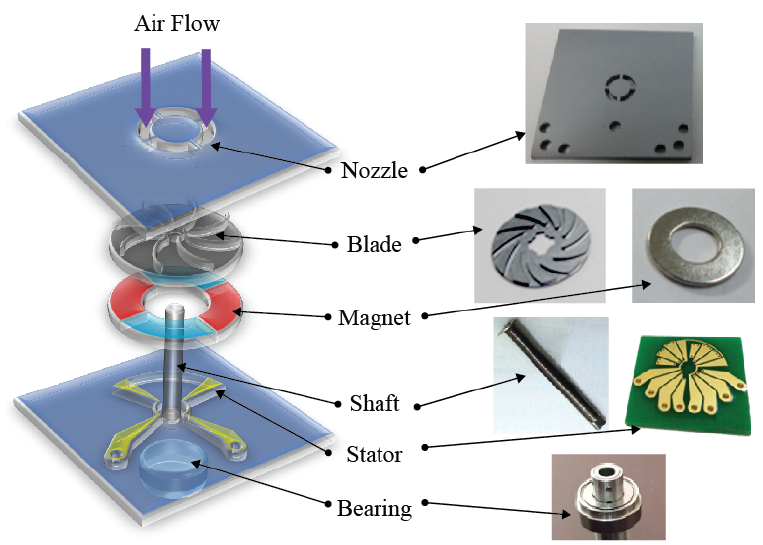
Figure 7. Part assembly diagram for open circuit output voltage experiment of the proposed rotor.